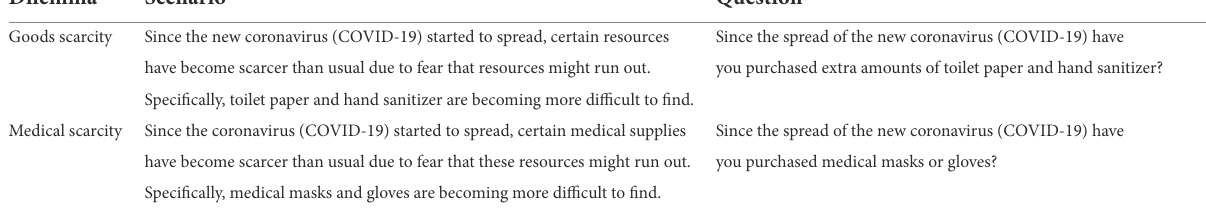
FIGURE 1 Age distribution.